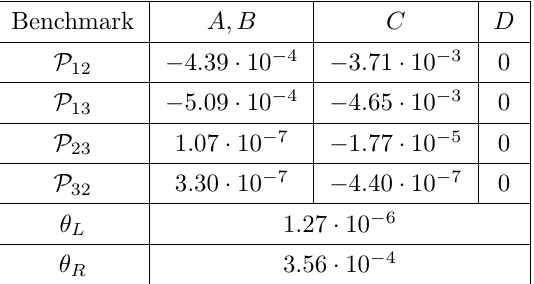
Table 3. Mixing parameters for the benchmark points as de(cid:12)ned in section 2.3. Benchmark points A and B have the same mixing angles. (cid:18) L;R are the same across all the benchmark points as they only depend on M and Y